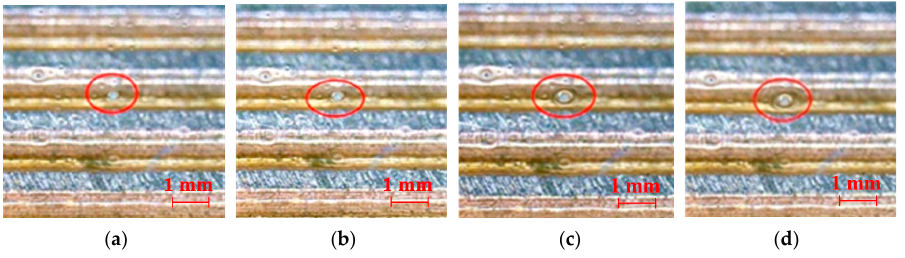
Figure 7. Boiling process of the MGFHP filled with anhydrous ethanol under 12 W: ( a ) 1 s; ( b ) 2 s; ( c ) 3 s; and ( d ) 4 s.